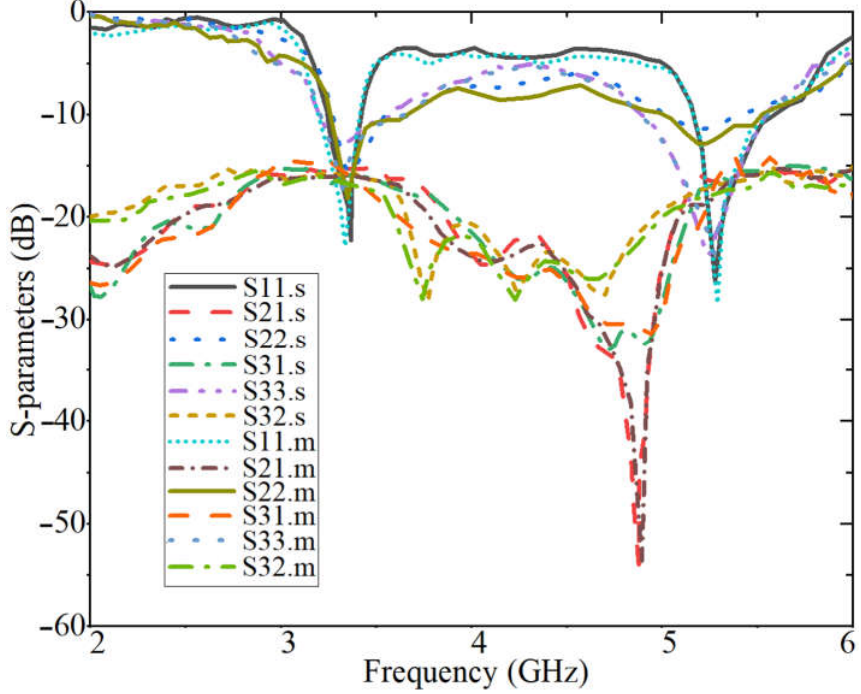
Figure 9. S-parameter results of the antenna in free space (off-body) (‘.s’ and ‘.m’ are the simulation and the measurement results, respectively).